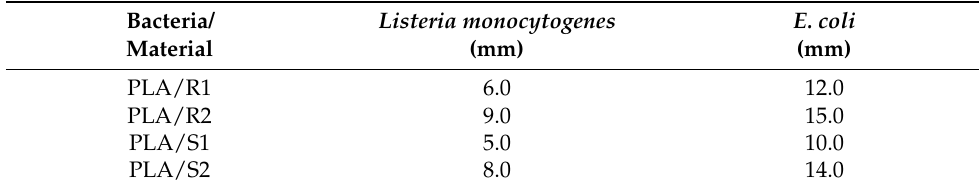
Figure 9. Antibacterial activity of compounds PLA/R1, PLA/R2, PLA/S1 and PLA/S2 and control on bacteria ( a ) Listeria monocytogenes and ( b ) E. coli. Table 3. Bacterial inhibition halos of compounds PLA/R1, PLA/R2, PLA/S1 and PLA/S2 and control on bacteria Listeria monocytogenes and E. coli